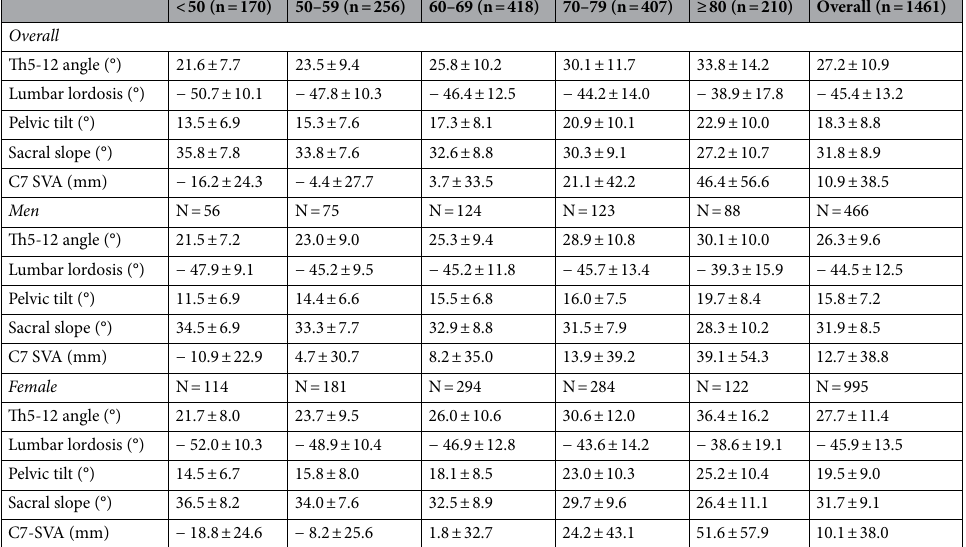
Table 2. Comparison of mean sagittal spinal alignment values among different age groups in the cohort. The data are shown as the mean ± standard deviation. Differences in the values of the indices were tested for significance using analysis of variance for comparisons among multiple groups. C7 SVA, sagittal vertical axis at